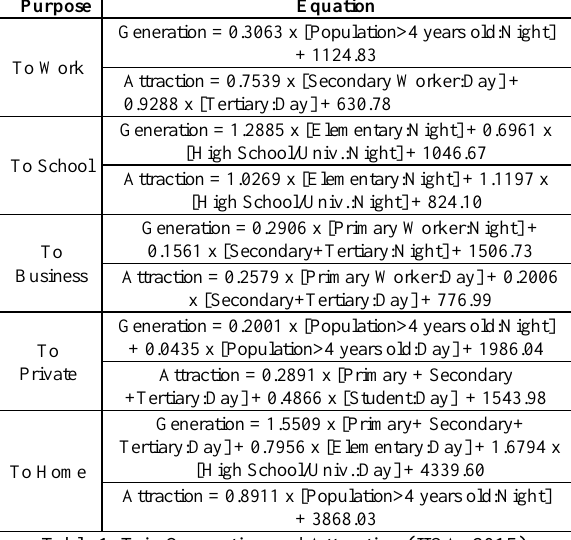
Table 1. Trip Generation and Attraction (JICA,